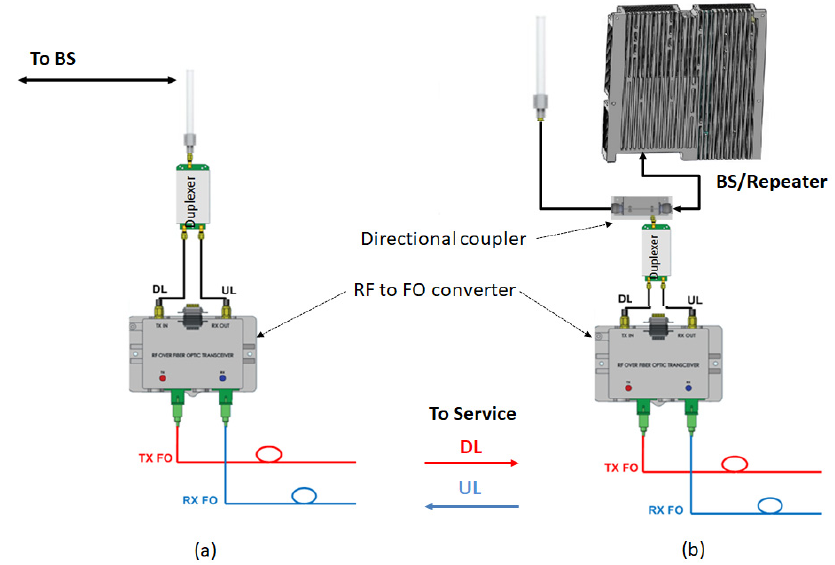
Figure 2. Pick-up modes: ( a ) by antenna, ( b ) direct connection to BS or repeater.